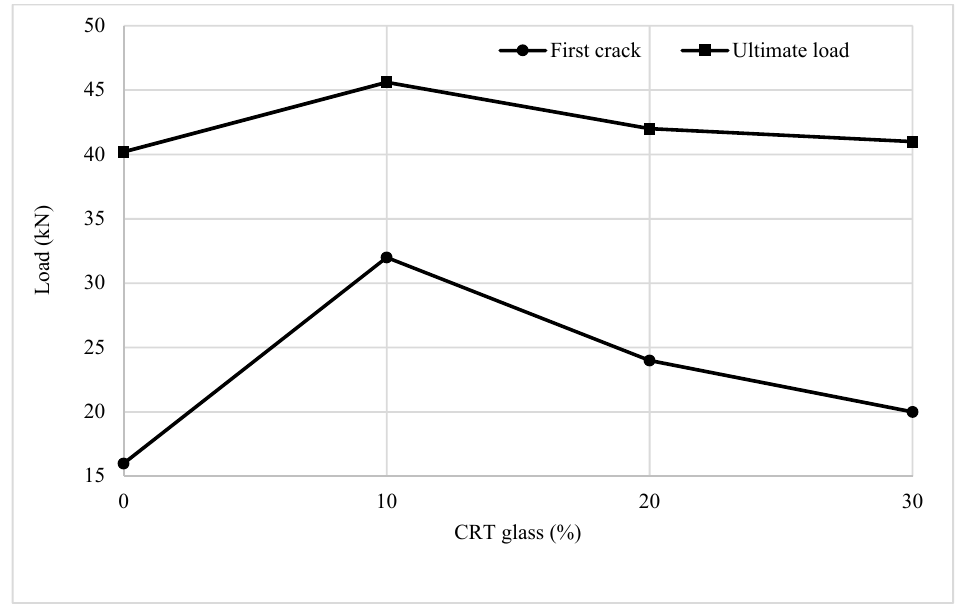
Figure 7: Load at first crack and ultimate load for all beams Figure 7. Load at first crack and ultimate load for all